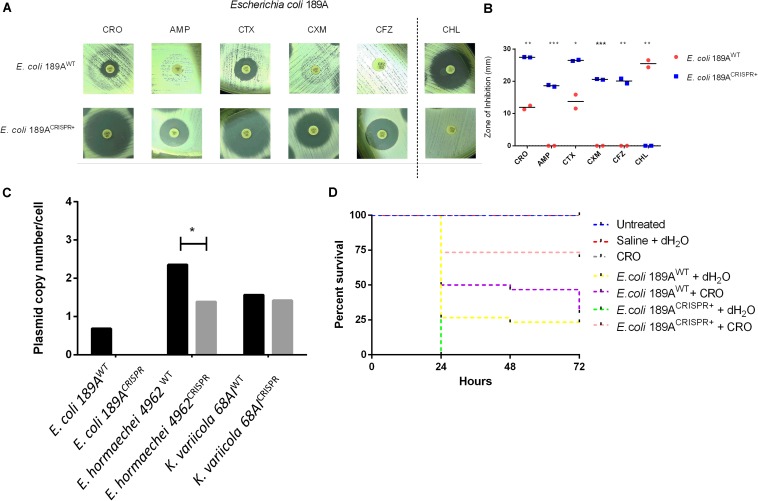
Effect of the CRISPR-Cas9-based interference with the blaTEM–1 gene in the clinical isolate of E. coli 189A. (A,B) Disk diffusion susceptibility test on E. coli grown on Mueller-Hinton agar with measurement of inhibition zones showing re-sensitization to ceftriaxone (CRO), ampicillin (AMP), cefotaxime (CTX), cefuroxime (CXM), and cefazolin (CFZ), along with acquired resistance against chloramphenicol (CHL), co-mediated via the CRISPR-Cas9 plasmid. WT, wild type; CRISPR+, presence of the CRISPR-Cas9 plasmid. Horizontal bars represent the mean of duplicate disk diffusion tests. *p < 0.05; **p < 0.01; ***p < 0.001. (C) Quantification of the blaTEM–1 plasmid in clinical isolates of Enterobacteriaceae before and after CRISPR-Cas9 treatment. qPCR-based amplification of the blaTEM–1 gene indicated plasmid clearance in E. coli 189CRISPR+ and plasmid maintenance in E. hormaechei 4962CRISPR+ and K. variicola 68AICRISPR+. (D) Percent survival rate of G. mellonella larvae after infection with either E. coli 189AWT or E. coli 189ACRISPR+ plus administration of ceftriaxone (CRO) or water 1 h post-infection. A higher proportion of larvae survived when infected with E. coli 189ACRISPR+ as opposed to those infected with E. coli 189AWT (p < 0.01), indicating re-usability of CRO upon treatment with CRISPR-Cas9-system. The data are the mean of three independent experiments, each performed with 10 larvae per treatment group (n = 30).